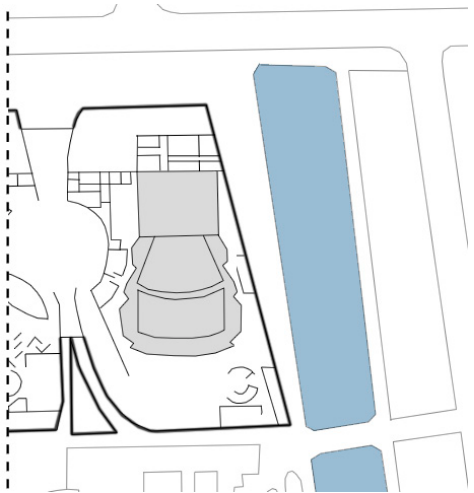
Figure 6. Fukuoka Symphony Hall in the Prefectural International Hall “Asian Cross Road Over the Sea”, graphic processing, based on [23] by E. Latusek.